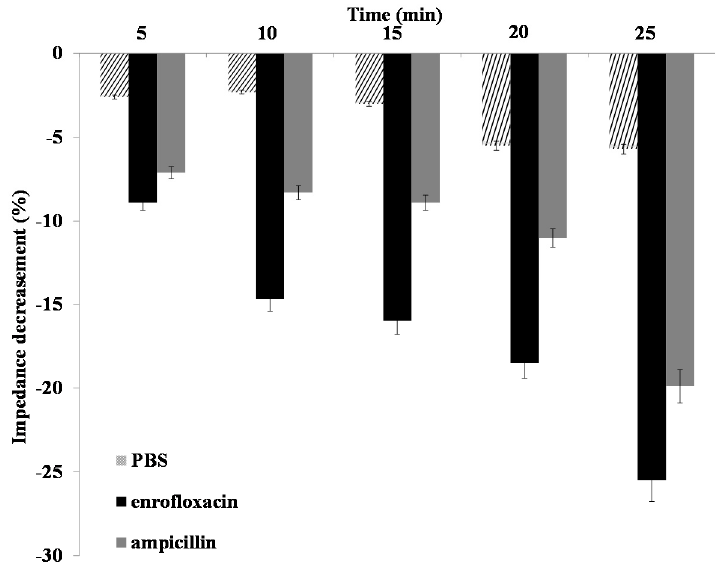
Figure 5. Time courses of the relative impedance amplitude signal changes of the nanoporous alumina membrane with GQDs with antibiotics function time.